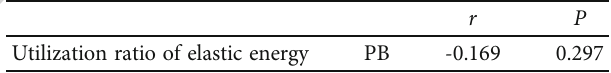
Table 2, the utilization ratio of elastic energy ( P = 0 : 297 ) had no signi fi cant correlations with personal best.